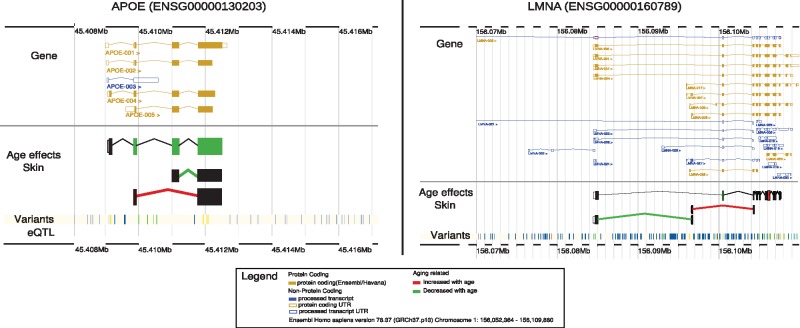
Age effect for APOE and LMNA. On the left, a scheme of the APOE gene and the multiple protein coding transcripts variants (yellow) and non-coding processed transcripts (blue) produced by the gene. In the skin tissue, three exons and one link decreased their expression with age (green-coloured exon and link between exons); and one link increase its expression (red-coloured link). On the right, a scheme of the LMNA gene and the age affects in the skin tissue. Two exons were affected in their expression by age by increasing expression (red coloured exon, corrected P-val < 0.1) and decrease expression with age (green-coloured exon). Furthermore, two links were significantly associated with age in their expression (corrected P val < 0.05). Our results suggested an increase in the production of isoforms using alternative 5’.